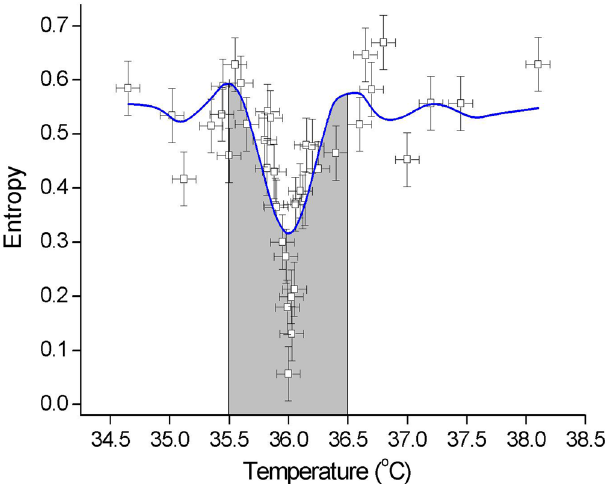
Figure 3. Dynamic entropy as a function of temperature. Approximate entropy (ApEn) data interpolated using the sinc function. The shading represents the attractor basin, which can be interpreted as a dynamic superconducting energy gap 1 K (0.0001 eV) wide with a dynamic Majorana quasi-particle peak in the centre. Fit parameters: coefficient of determination R 2 = 0.6259 ( χ 2 = 0.007), y 0 = 0.54(2), a = − 0.23(3), b = 8.9(9) to a sin ( bx ) . y y 0 x = +